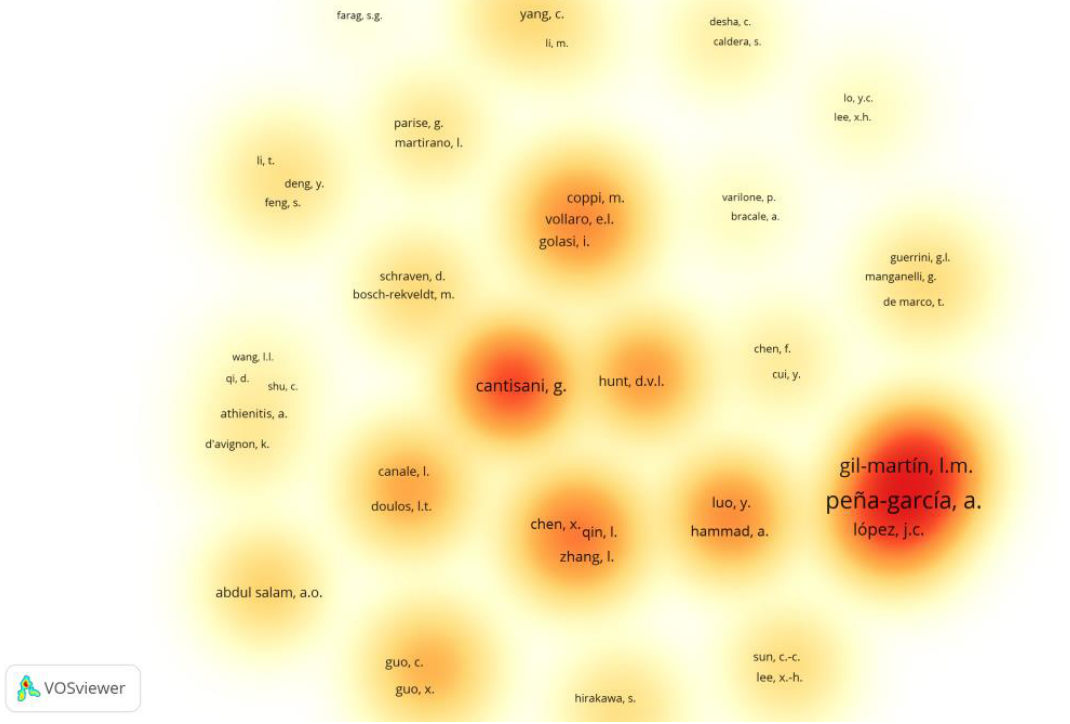
Figure 2. Density visualisation of potential author matches.